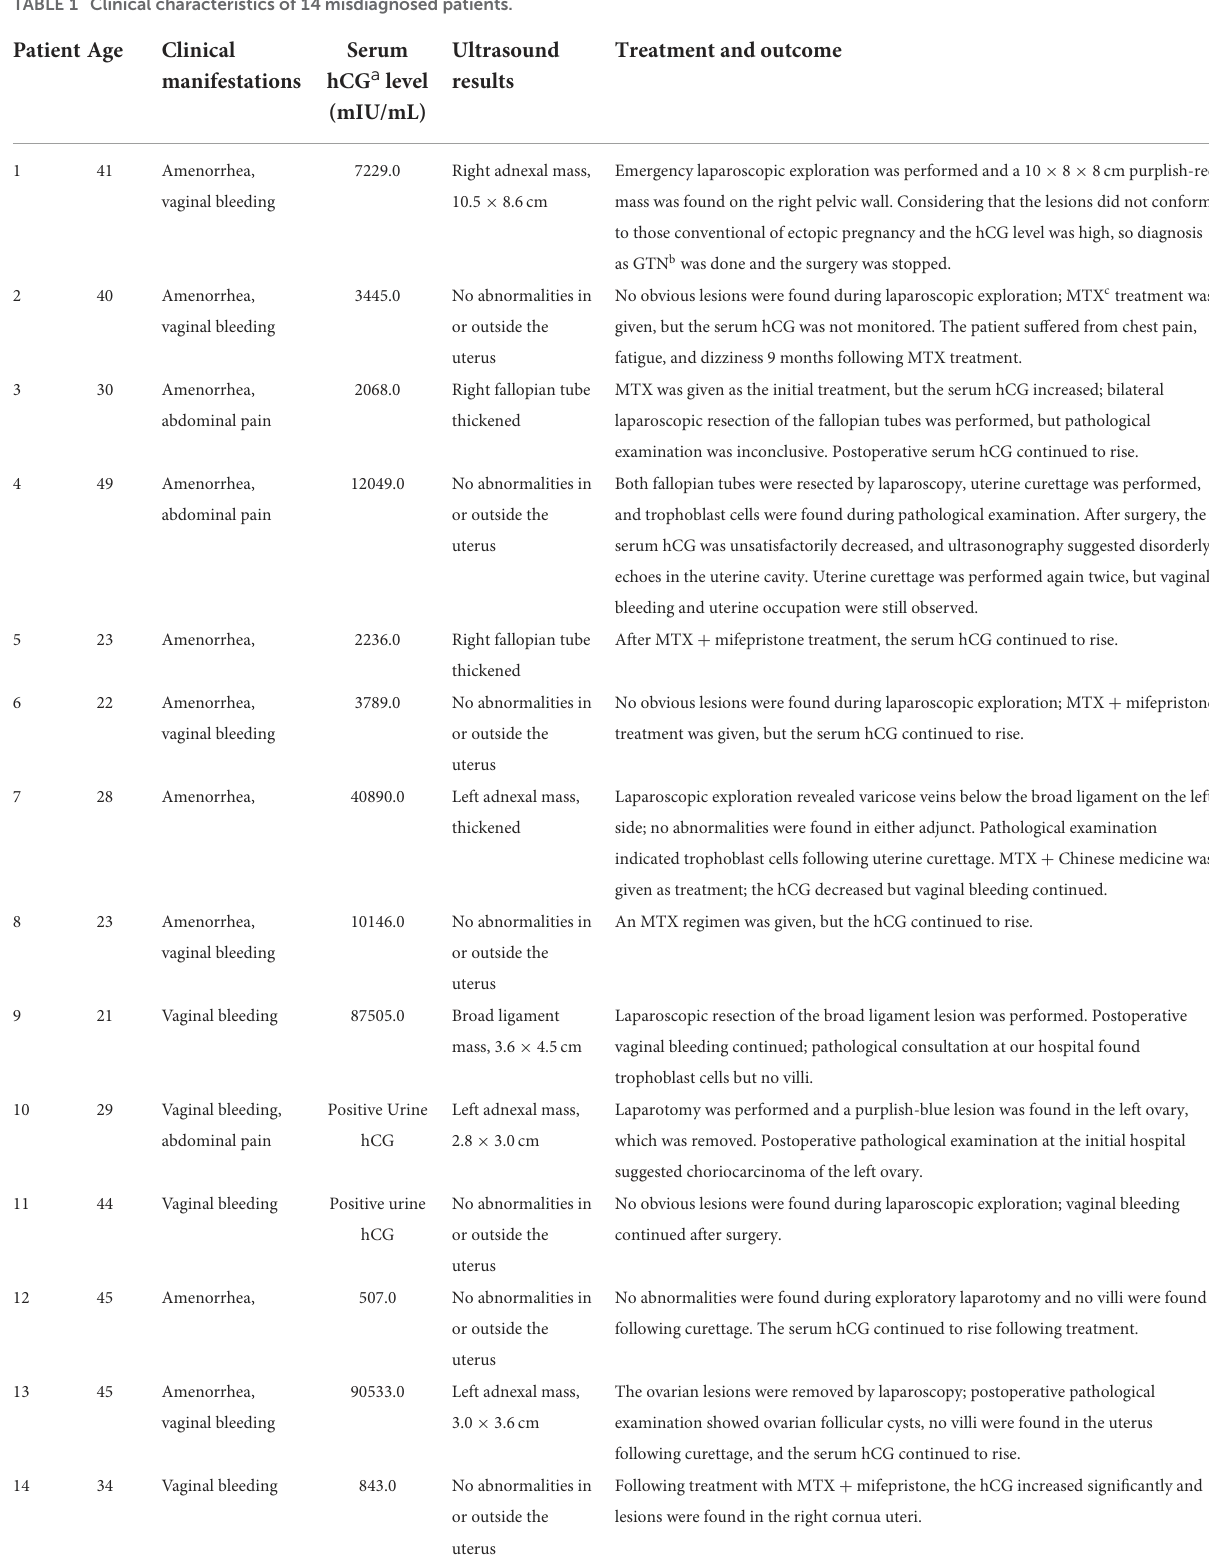
TABLE 1 Clinical characteristics of 14 misdiagnosed